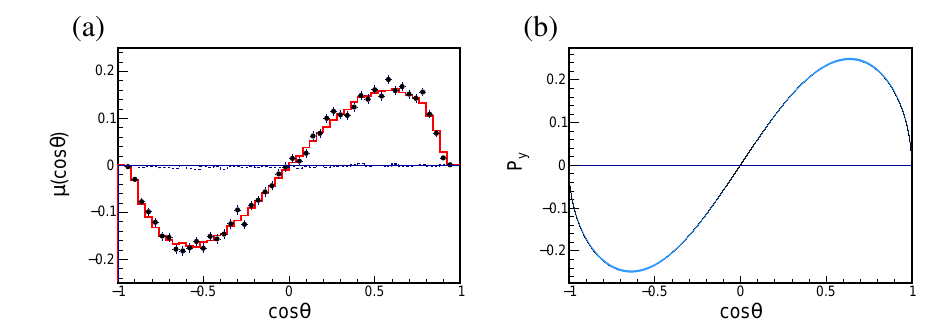
Figure 1. (a) Moment µ (cos θ ) as a function of cos θ for e + e − → J /ψ → ( Λ → p π − )( ¯ Λ → ¯ p π + ). The points with error bars are the BESIII data, and the solid-line histogram is the global fit results. The dashed histogram shows the no polarization scenario ( W ( ξ ;0 , 0 , 0 , 0) ≡ 1). (b) Polarization of Λ as a function of cos θ calculated using the determined values of α ψ and ∆Φ .